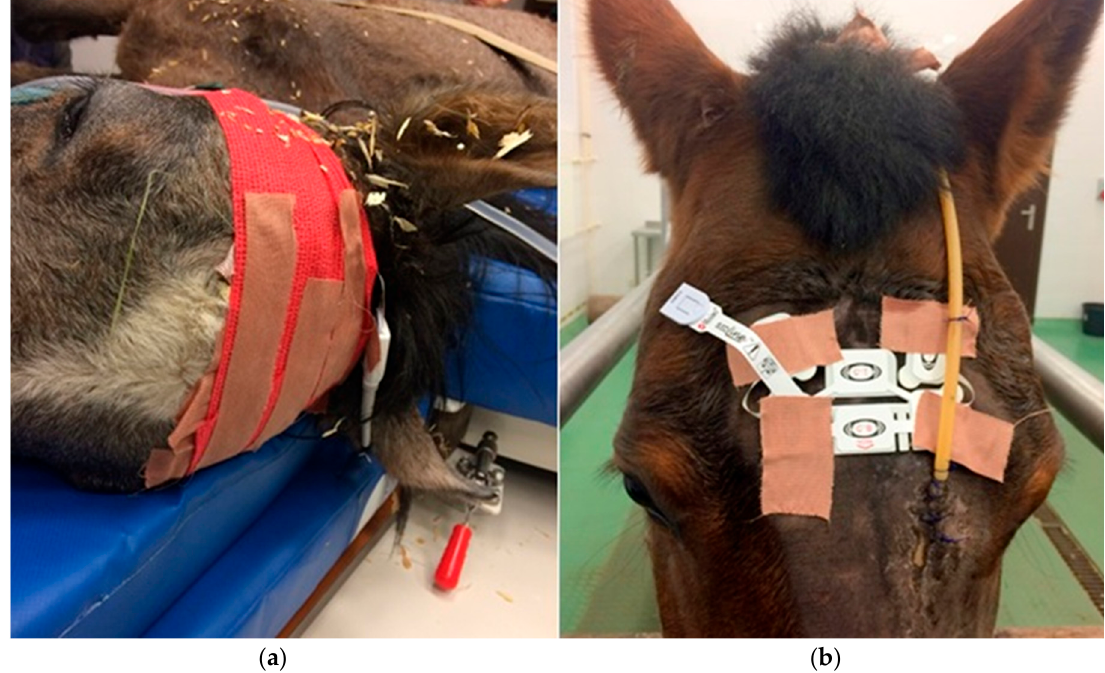
Figure 1. Placing of electroencephalography (EEG) electrodes on the parietal part of the skull in a horse ( a ) during general anesthesia and ( b ) standing anesthesia.